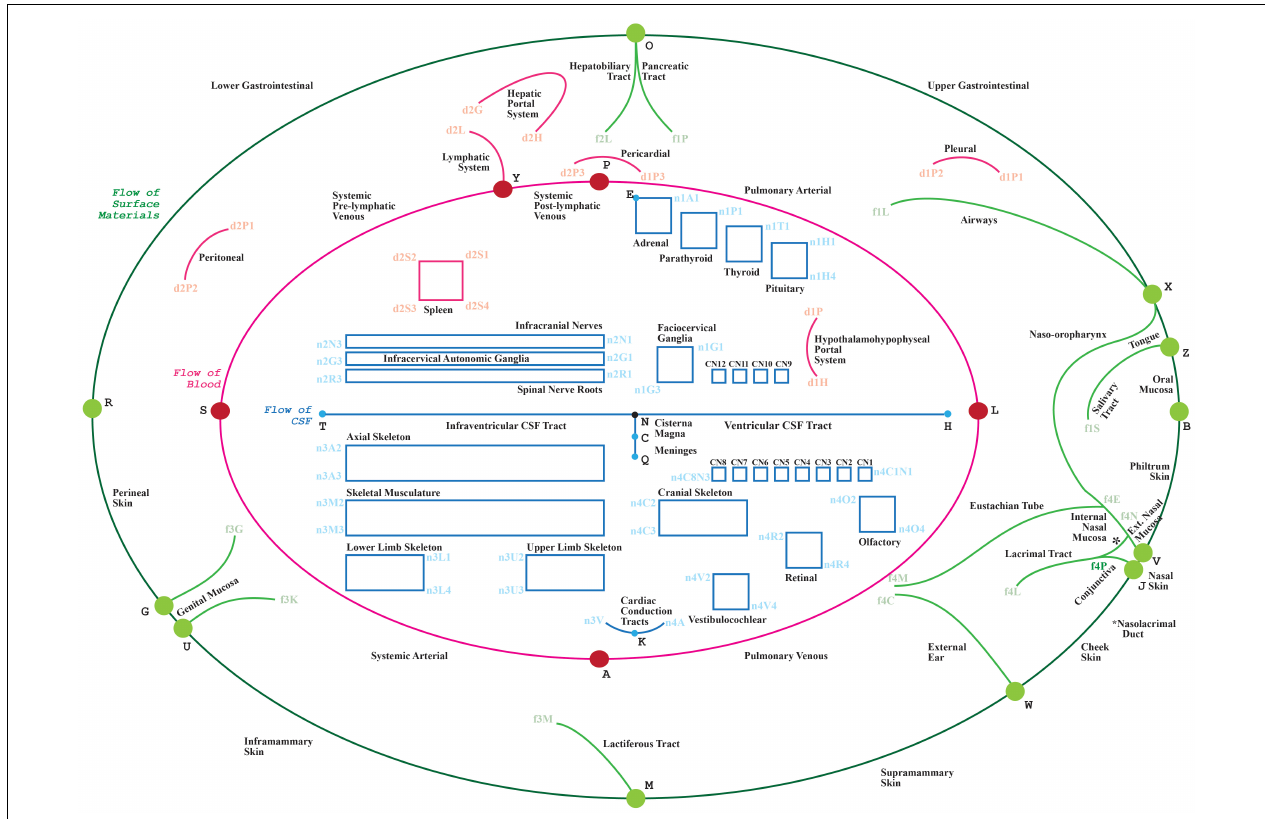
FIGURE 1 | The visual depiction of a TOO map. Lines represent the main thoroughfares of material transit as follows: Green: surface material; Red: blood, lymph and mesothelial fluids; Blue: cerebrospinal fluid; cytosol of cardiac conduction syncytium. Rectangles act as bounding boxes for conduits that belong to anatomical structures as